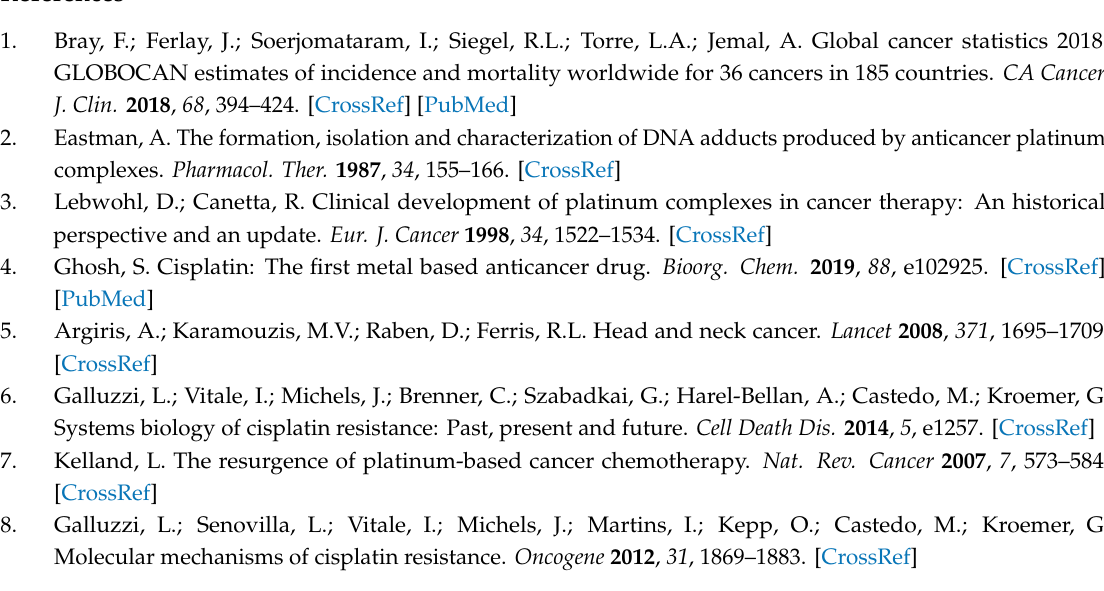
Table S1: Information of top 100 genes upregulation in the CR cells. The average fold change and p -value were listed, Table S2: Information of top 100 genes upregulation in the CR cells. The average fold change and p -value are listed, Table S3: Gene ontology analysis of all CR-associated genes, Table S4: List of primers used in the present study. Figure S1: Original immunoblotting images presented in the